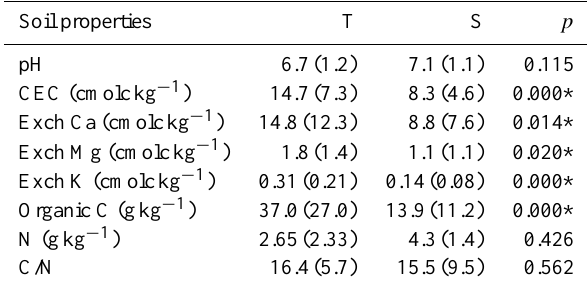
Table 3. Considered chemical properties for topsoil (T) and sub- soil (S) samples. Standard dev. in brackets ( n = 41), significance levels expressed by p-values (CEC: cation exchange capacity; * sig- nificant differences between values in the same lines, p <